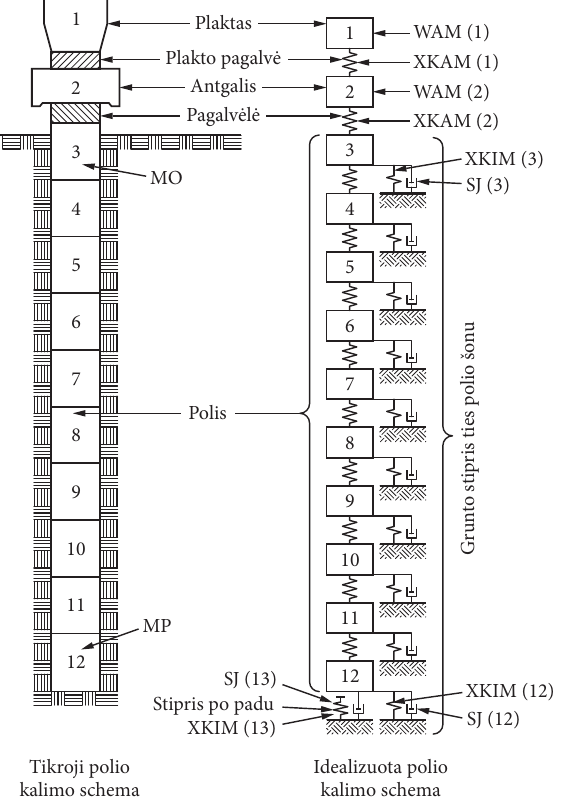
Fig. 2. Idealization of pile test or hammering